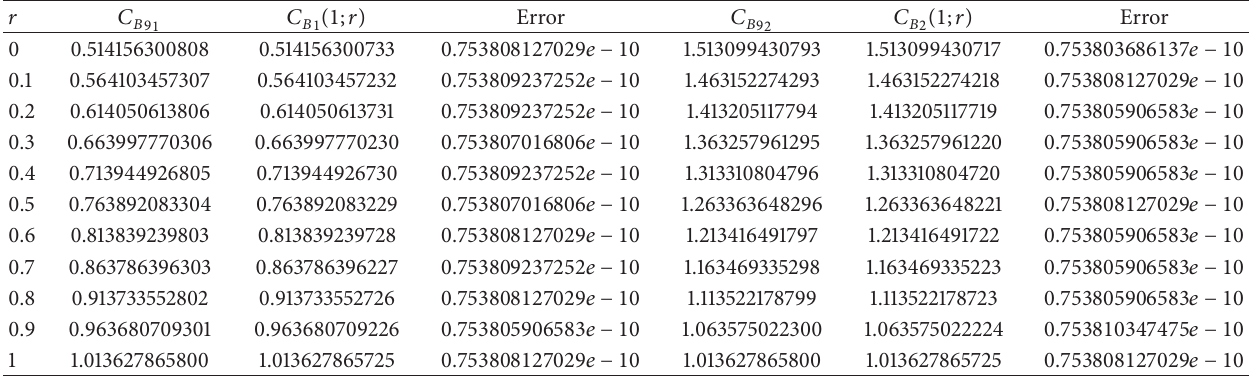
Table 3: The result of the proposed method for Example 27 with V = 𝛼 = 0.85 , 𝑚 = 9 , 𝑘 1 = 0.014 , and 𝑘 2 = 0.001 .